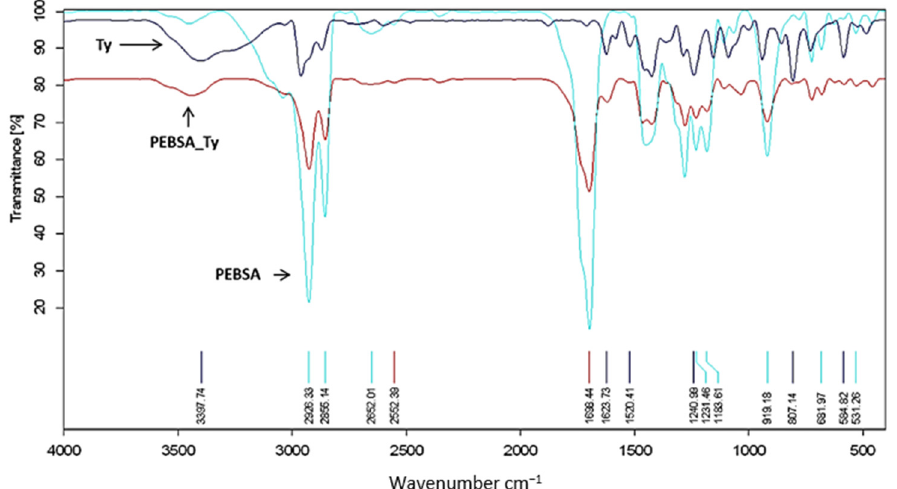
Figure 4. PEBSA, PEBSA_Ty, and thymol FTIR spectra.